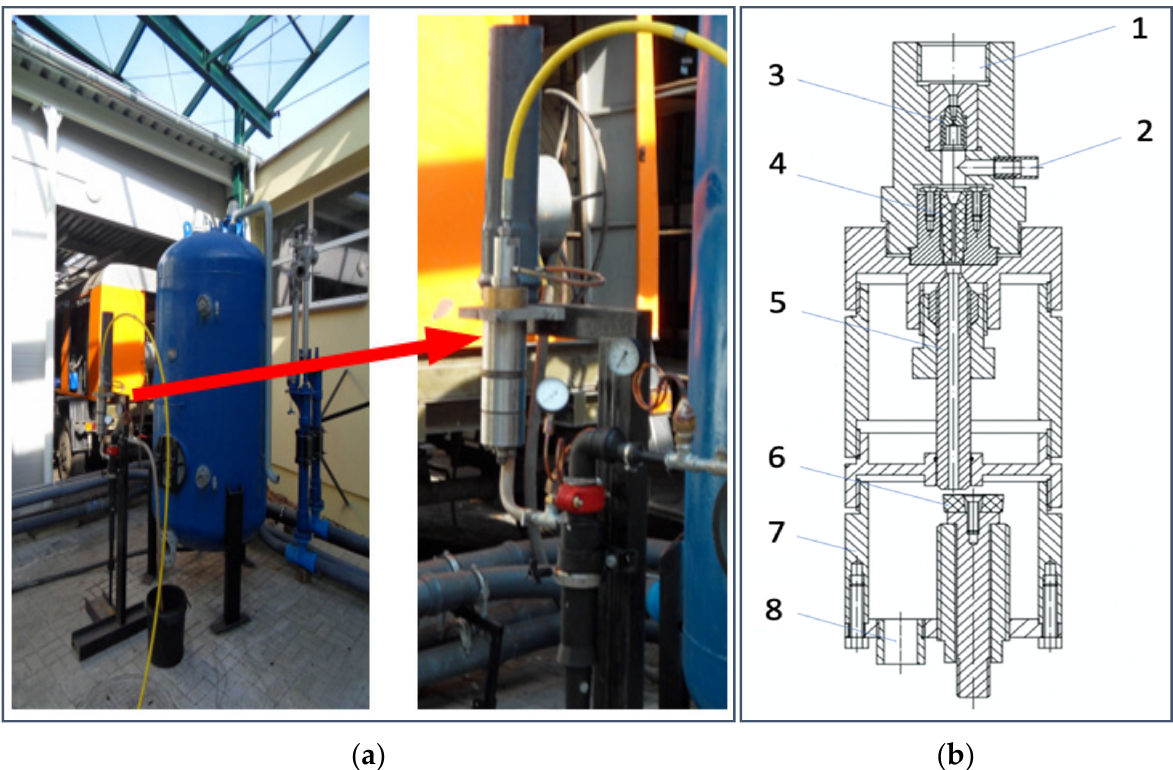
Figure 2. Vertical hydro-jet mill: ( a ) General view of comminuting installation; ( b ) Draft of a hydro-jet mill: 1—HP water inlet, 2—raw coal inlet, 3—water nozzle, 4—comminuting nozzle, 5—homogenizing nozzle, 6—comminuting disk, 7—shredding chamber, 8—coal slurry outlet.